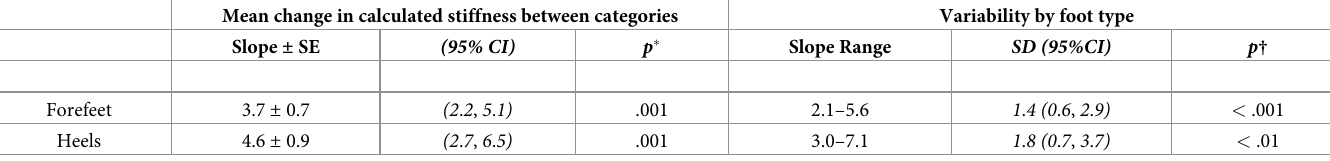
Table 3. Summary statistics from linear mixed effects regression models of calculated stiffness on stiffness categories and foot